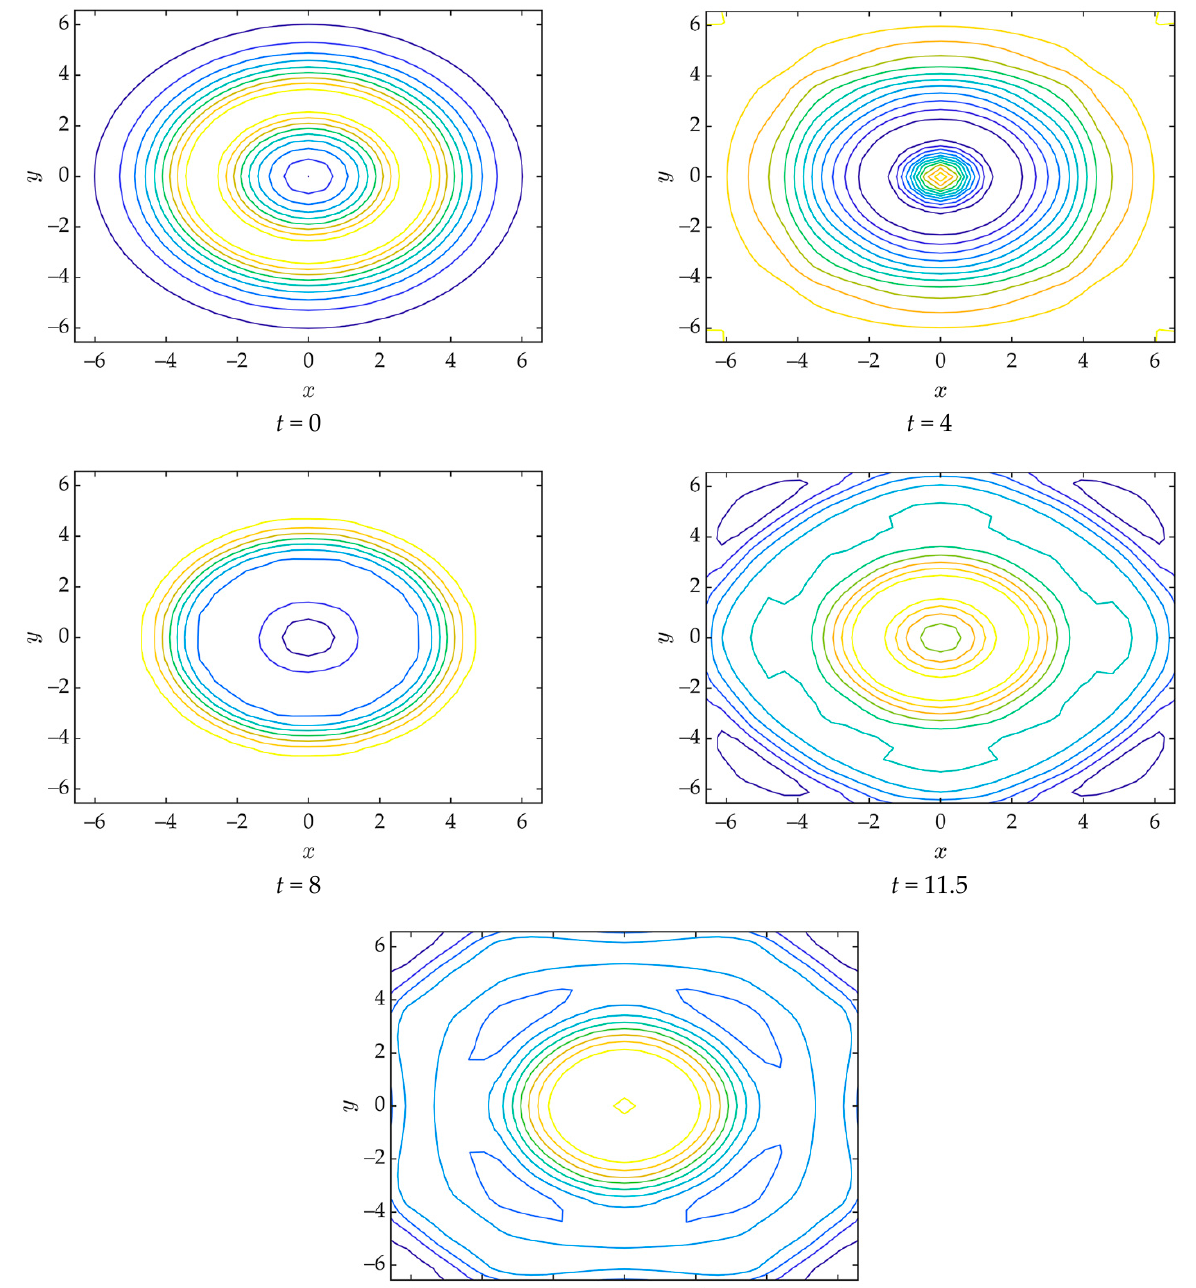
Figure 5. Contours of the circular ring soliton sin( u /2) at different times for Case II of Example 3.